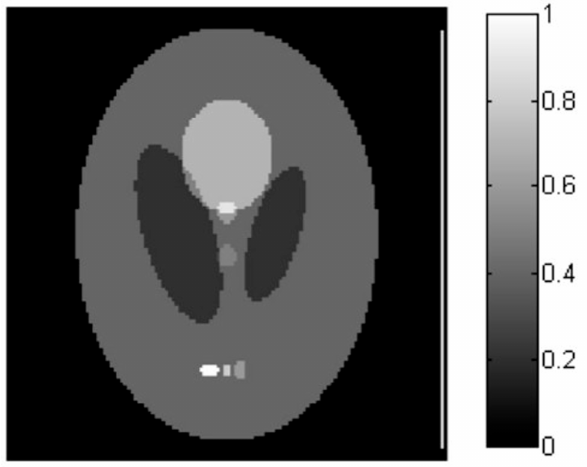
Figure 2. The Sheep–Logan phantom and the diagram for the straight-line scanning.